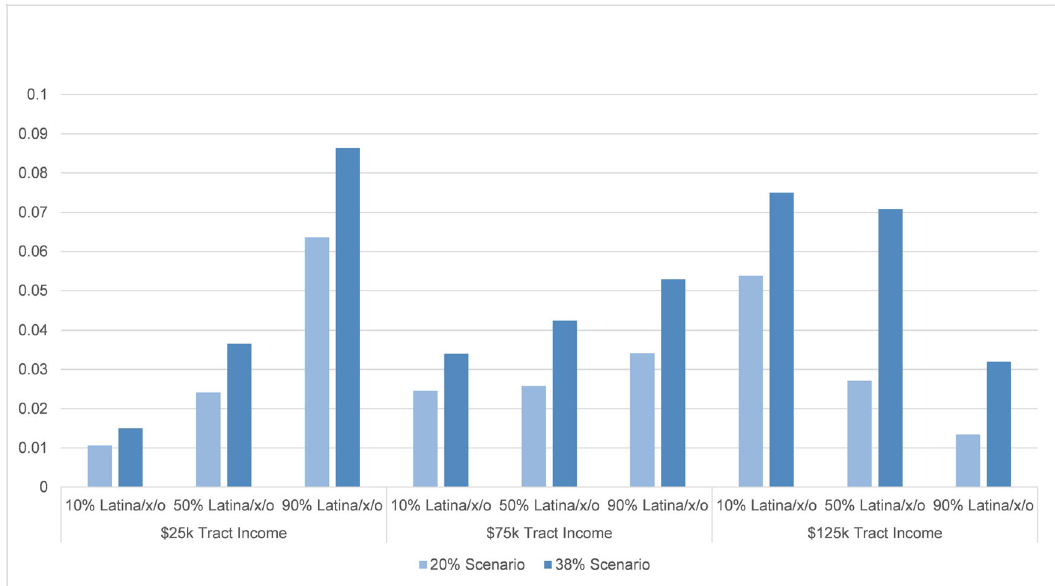
Fig. 4 Predicted probabilities of parcel fl ooding only because of climate change. Predicted probabilities calculated for binary logistic regression results in Table 2 at levels of percent Latina/x/o, for Hurricane Harvey in Harris County, TX.